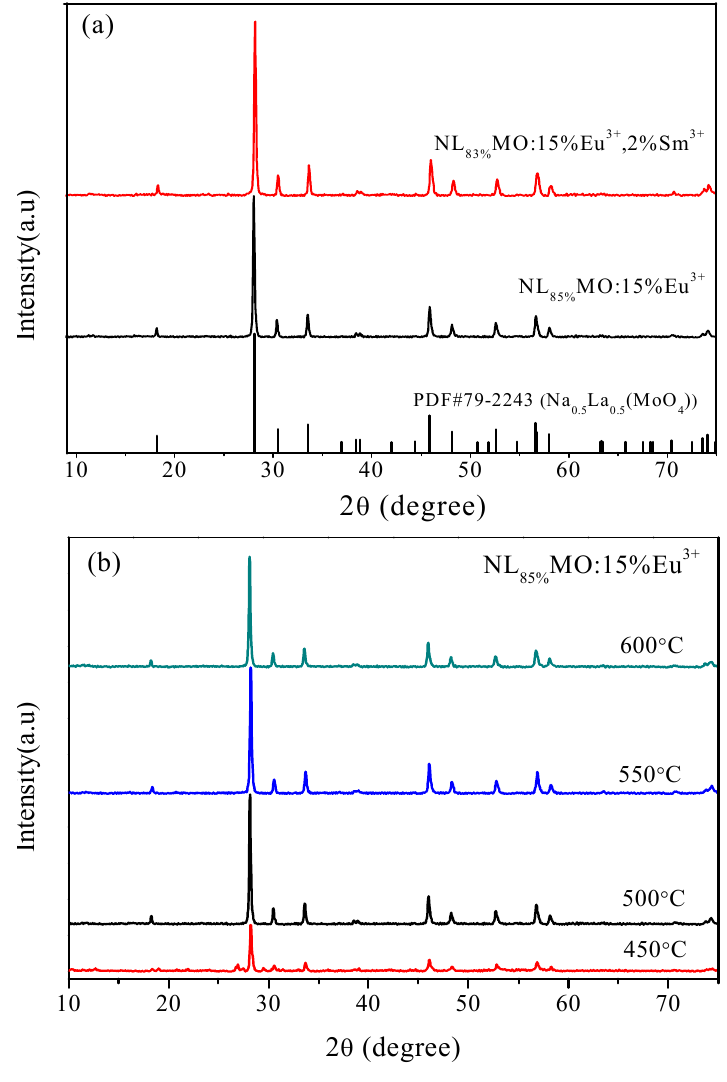
Figure 1. XRD patterns of ( a ) NL 83% MO:15%Eu 3+ ,2%Sm 3+ and NL 85% MO:15%Eu 3+ obtained at 550 °C and ( b ) NL 85% MO:15%Eu 3+ formed at different temperatures for 6 h.